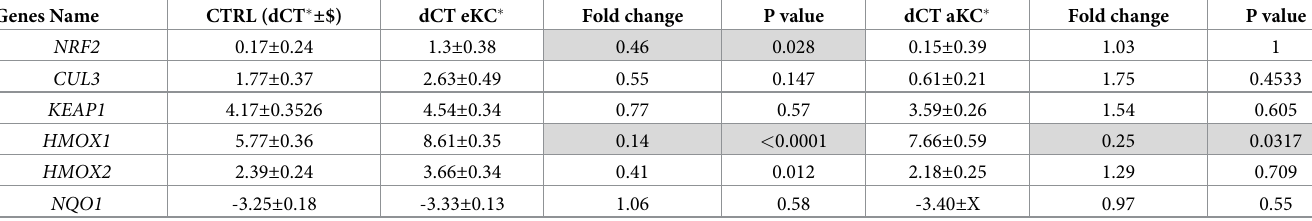
Table 3. Transcript relative expression of NRF2 pathway genes in control and keratoconus corneal